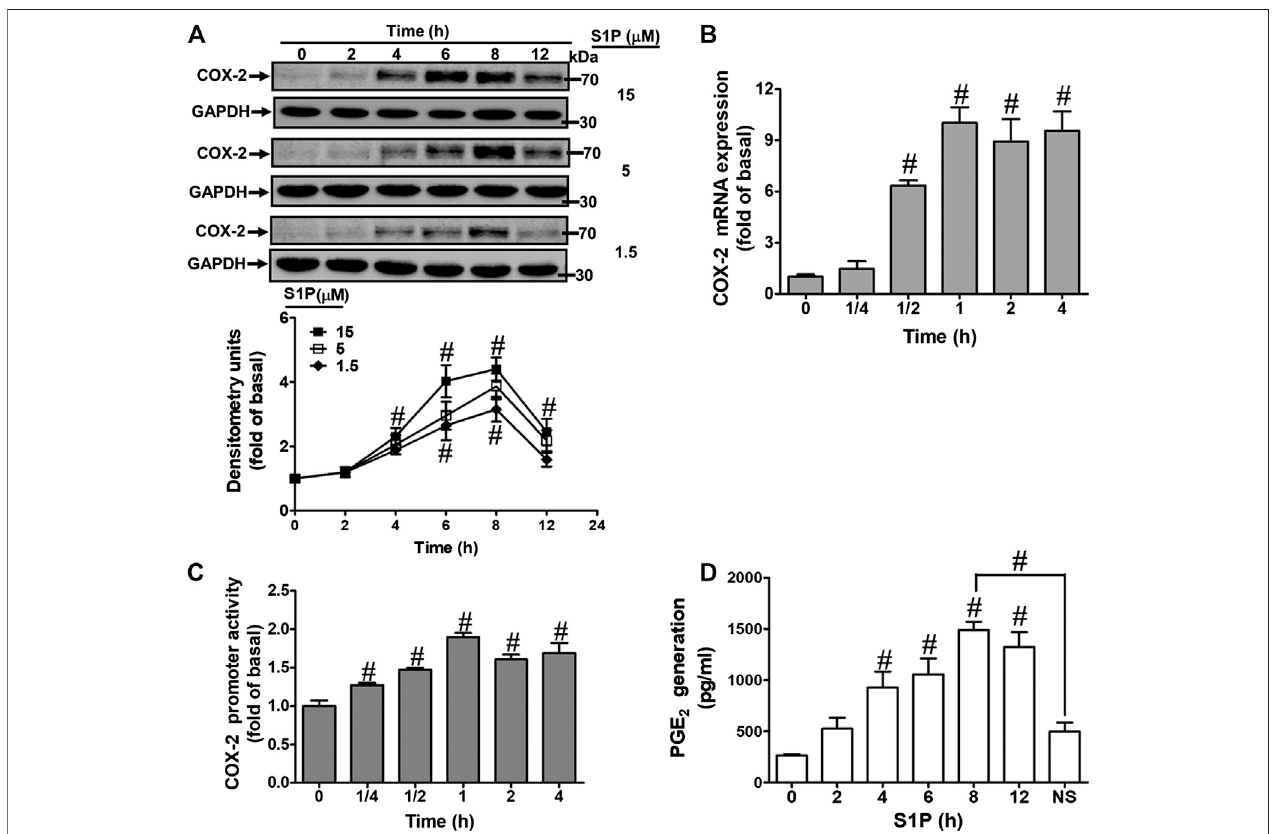
FIGURE 1 | S1P induced COX-2 expression and PGE 2 generation in HCFs. (A) Cells were incubated with various concentrations of S1P for the indicated time intervals. (B) Cellswereincubated with15 μ MS1Pfortheindicatedtimeintervals.COX-2mRNAwasanalyzedbyrealtime-PCR. (C) CellsweretransfectedwithaCOX- 2 promoter-luciferase reporter gene and then incubated with 15 μ M S1P for the indicated time intervals. The promoter reporter assay was determined. (D) Various concentrations of S1P were used to treat the cells for the indicated time intervals. In addition, cells were pretreated with NS398 (10 μ M) for 1 h and then incubated with15 μ MS1Pfor8 h.ThemediawerecollectedtodeterminePGE 2 levelsbyEIA.Dataareexpressedasmean ± SEMofthreeindividualexperiments(n (cid:2) 3). # p < 0.05, as compared with the cells treated with vehicle (DMSO) alone.